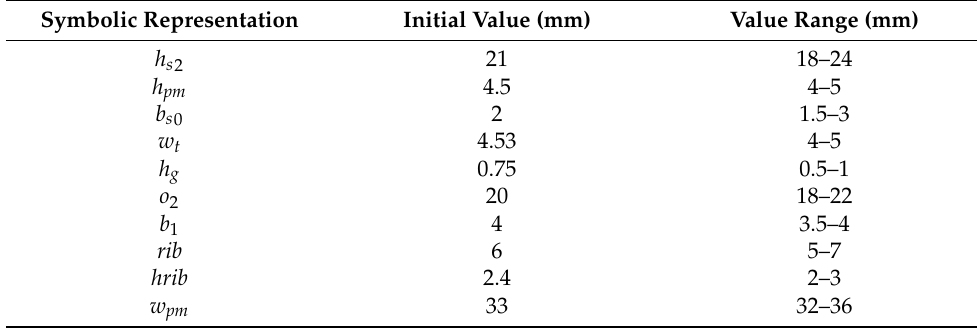
Table 2. Initial values and value ranges for optimization variables. Symbolic